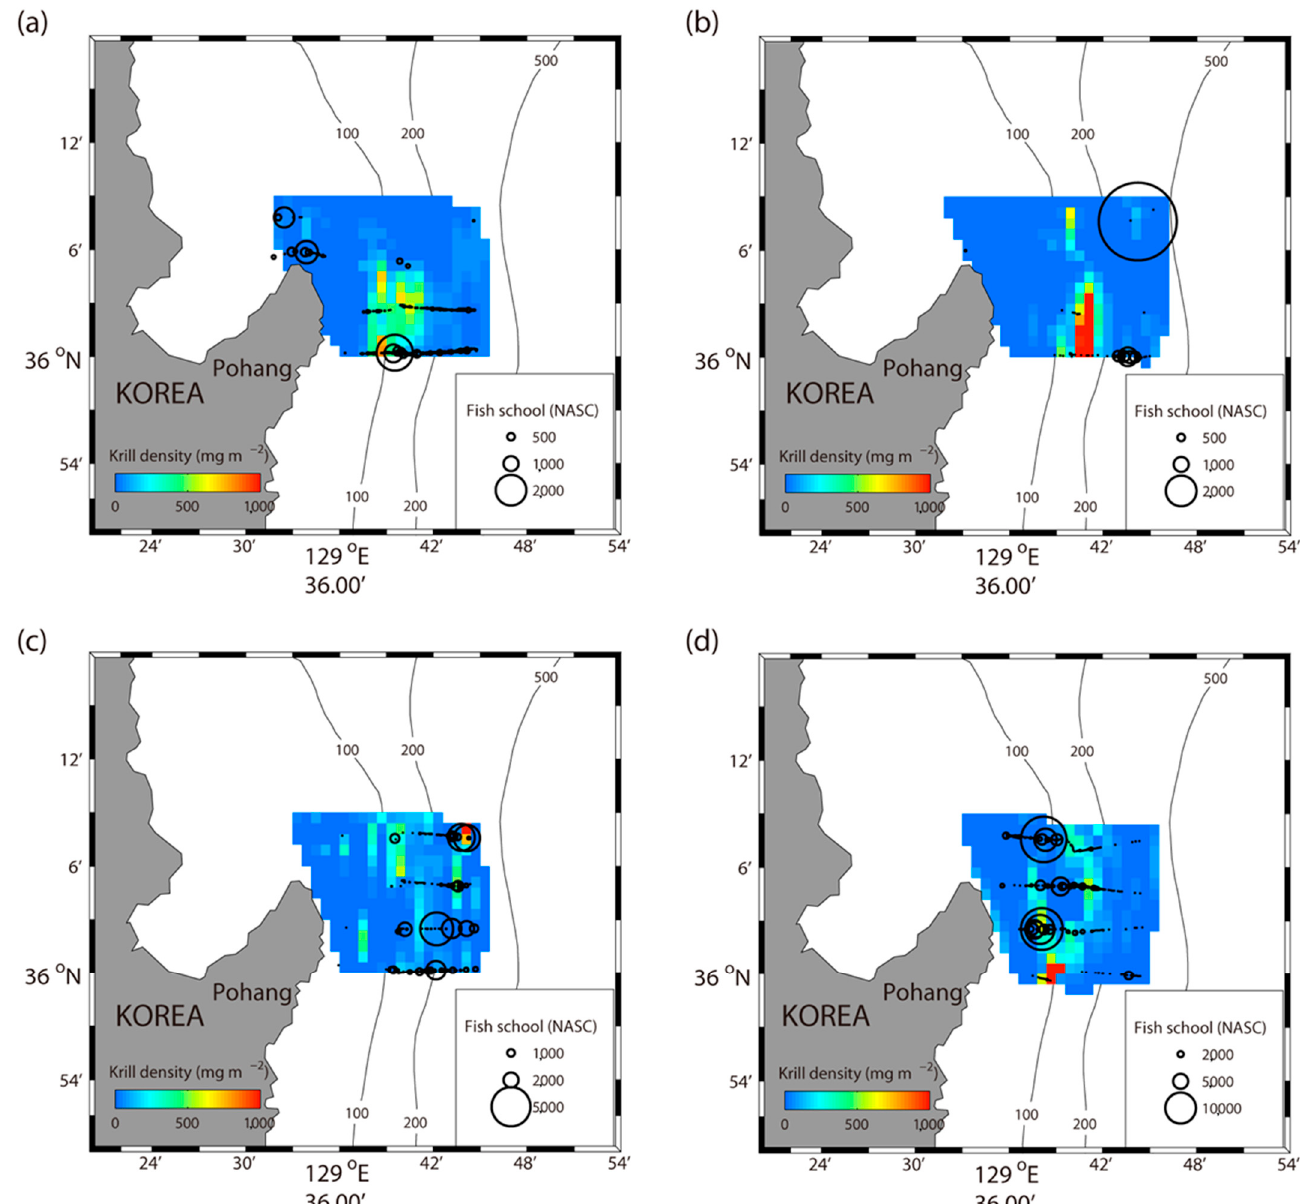
Figure 5. Map of the monthly concentration of Euphausia pacifica and fish schools. Sizes of the black circles correspond to the concentration of fish schools in the transects where acoustic data were collected. Interpolated measurements of E. pacifica are shown in the background. April ( a ); May ( b ); June ( c ); July ( d ).